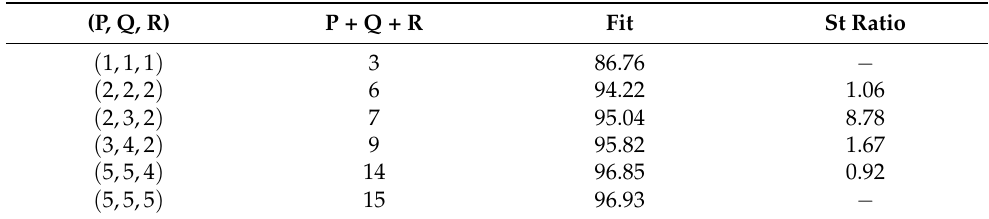
Table 2. Best solutions according to the CHull